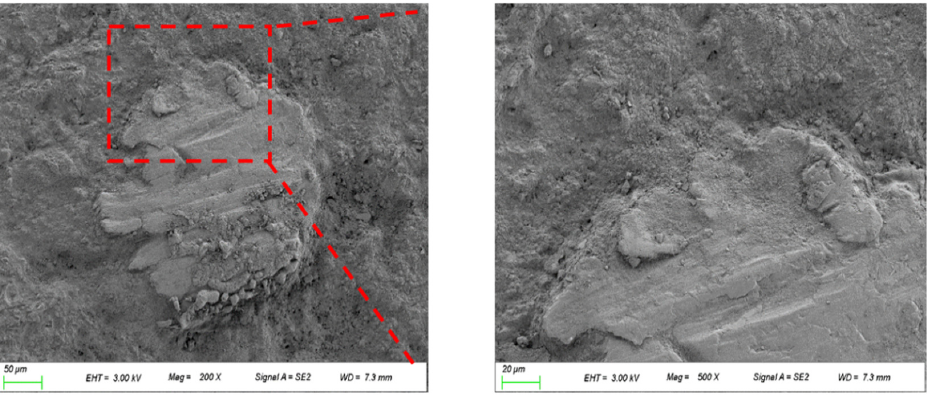
Figure 10. A typical SEM image of sample R100.